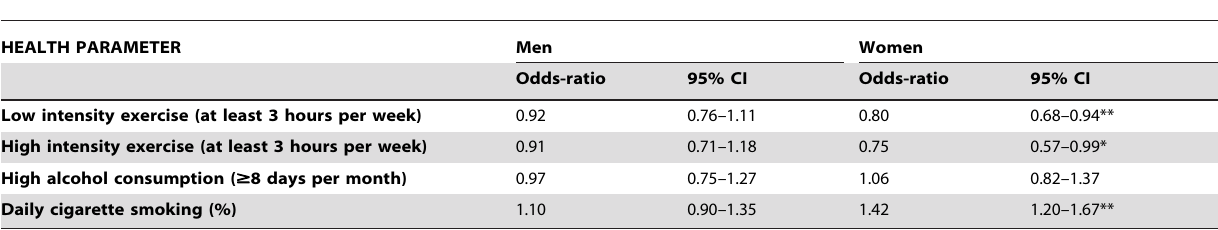
Logistic regression analysis using Global Seasonality Score (GSS) as the predictor variable and objective health risk factors/health behaviours as criterion variables (n=11,544). The analyses are adjusted for annual income, education, marital status, month of completing the questionnaire, urban/rural residence and sleep duration. CI: Confidence Interval. *P ,